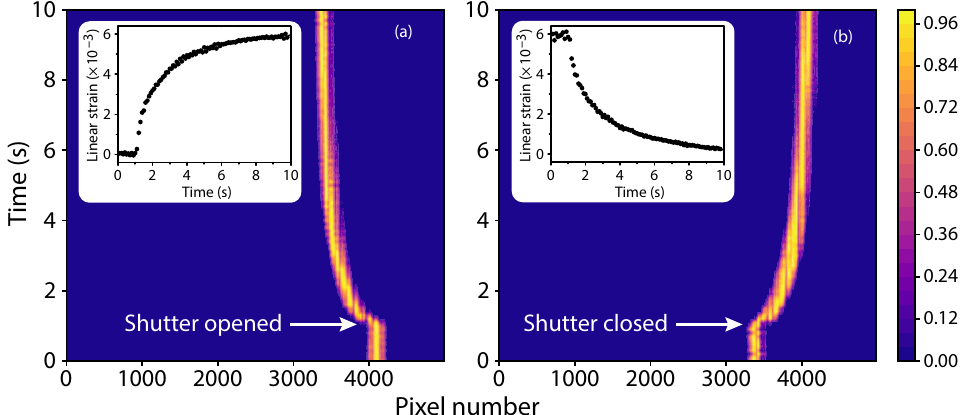
Figure 3. ( a ) A contour plot of the normalized diffraction beam profile incident on the linear CCD array as a function of time when a 15.1mW, 532nm pump laser is incident on the sample. The color bar on the right side of the graphs is given from 0 to 1 because the data was normalized (and not because of detector saturation). The inset shows the strain as a function of time calculated from the change in peak position of the diffracted probe beam determined from Gaussian fits. ( b ) A second contour plot showing the diffracted beam returning to its initial position on the linear CCD array when the pump beam is